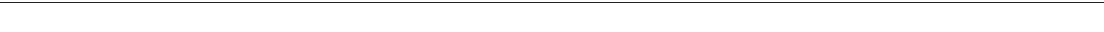
Fig. 2 Loss of Krt76 leads to enlarged lymph nodes and spleen, without affecting tongue and stomach epithelial homoeostasis. Immunostaining ( a )